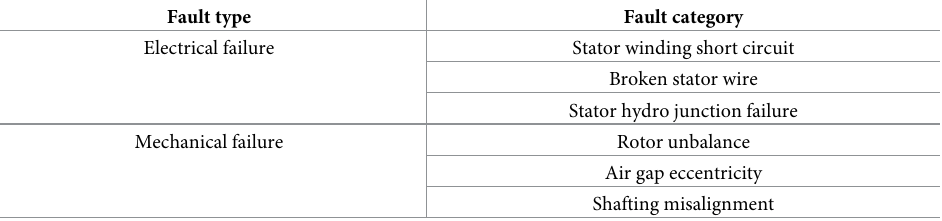
Table 4. Types of generator faults.